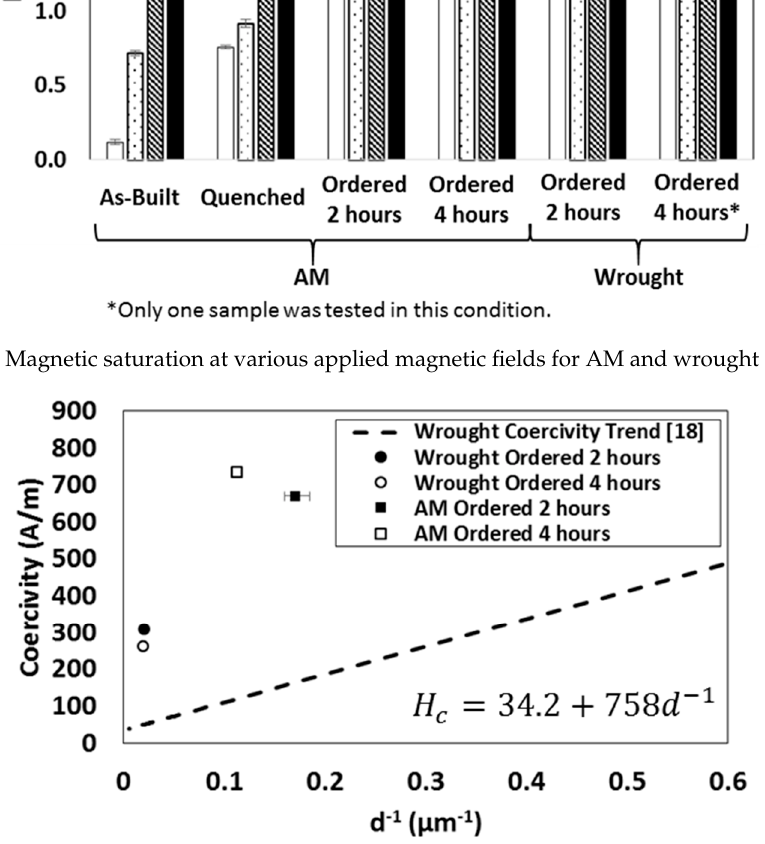
Figure 9. Coercivity data for wrought and AM materials after ordering for two or four hours compared to a previously reported grain size relationship for Fe-Co-2V.